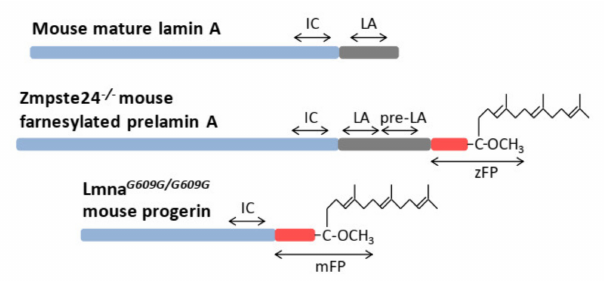
Figure 3. Schematic representation of the surrogate peptides selected for the measurement of mature lamin A, farnesylated prelamin A, and progerin in mouse samples: internal control peptide ( IC ), lamin A peptide ( LA ), prelamin A peptide ( pre-LA ), Zmpste24 − / − farnesylated prelamin A peptide ( zFP ), and Lmna 609G/G609G mouse farnesylated peptide ( mFP ).